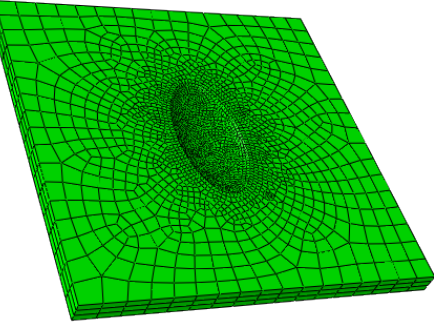
Figure 2. Mesh generation of a cold-rolled sheet.